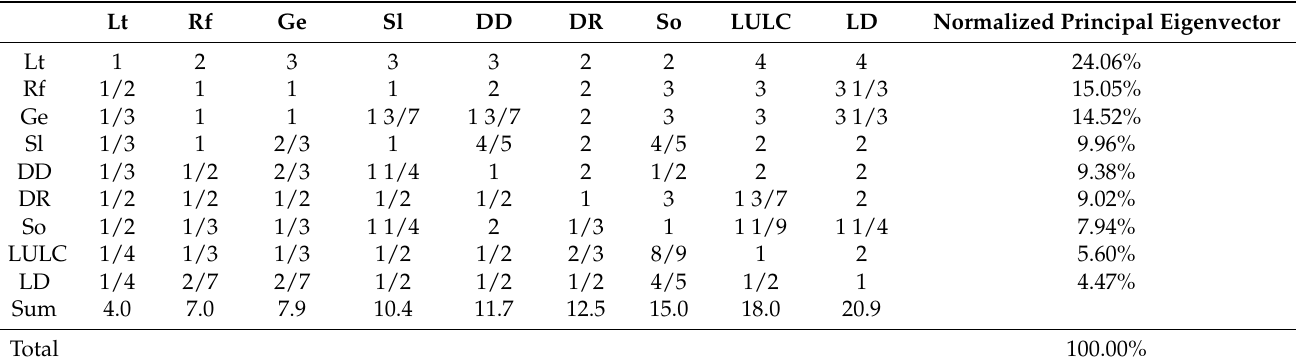
Table 4. A (9 × 9) pairwise comparison matrix for the analytic hierarchy process (AHP)-based groundwater potential (GWP) zoning.